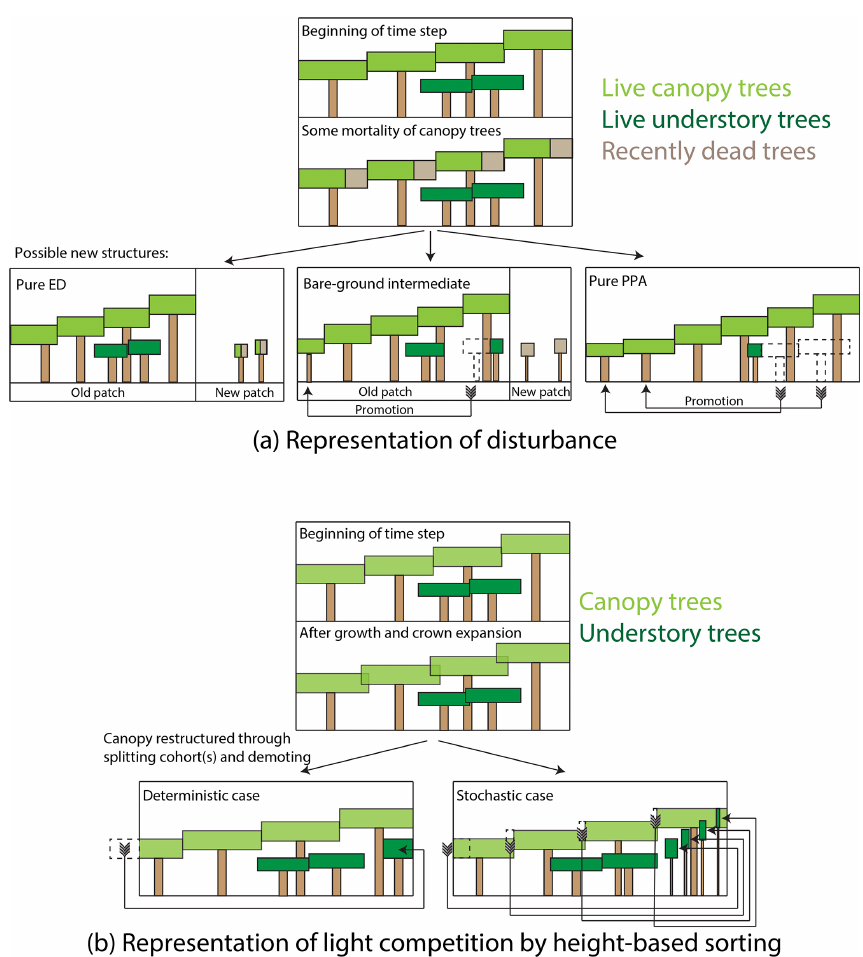
Figure 2. Schematic of how disturbance and height sorting are represented in the FATES model. (a) Representation of disturbance. When canopy trees die, some fraction of the crown area of the dead trees is transferred to a newly disturbed patch, while the remainder remains in the old patch. Trees can be promoted from the understory to the canopy either in the old patch or if they are transferred to the new patch area as survivors of the disturbance event. Endmembers of this case are the “pure-ED” case, in which all crown area becomes new patch area, and the “pure-PPA” case, in which no newly disturbed patch area is created. We also consider an intermediate case, in which half of the dead tree canopy becomes disturbed, but with no survivorship of trees in the newly disturbed patch. (b) Representation of height sorting. When canopy tree crown area exceeds the patch area that the trees are on due to crown growth, canopy trees are “demoted” to the understory. In the deterministic case, trees are rank-ordered by height and the shortest cohort is split at the point where total tree crown area equals patch area, and the remaining cohort is demoted. In the probabilistic case, all canopy trees are demoted, with the fraction of each cohort demoted based on the cohorts’ relative